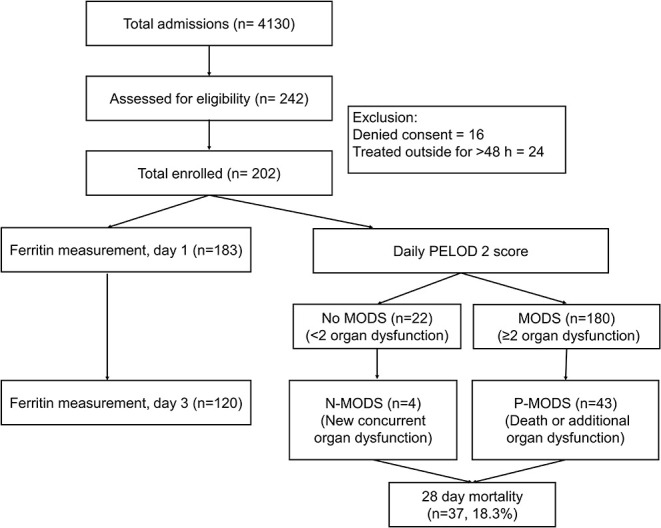
Study flow diagram.